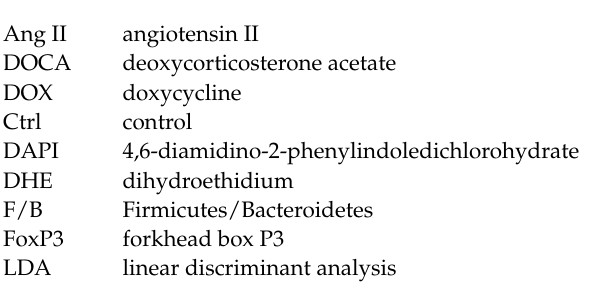
pathway; Figure S3: Effects of doxycycline (DOX) treatment on vascular inflammation; Table S1: Oligonucleotides for real-time RT-PCR; Table S2: Morphological parameters of all experimental groups; Table S3: Effects of Doxyciclyne (DOX) treatment on phyla changes in the gut